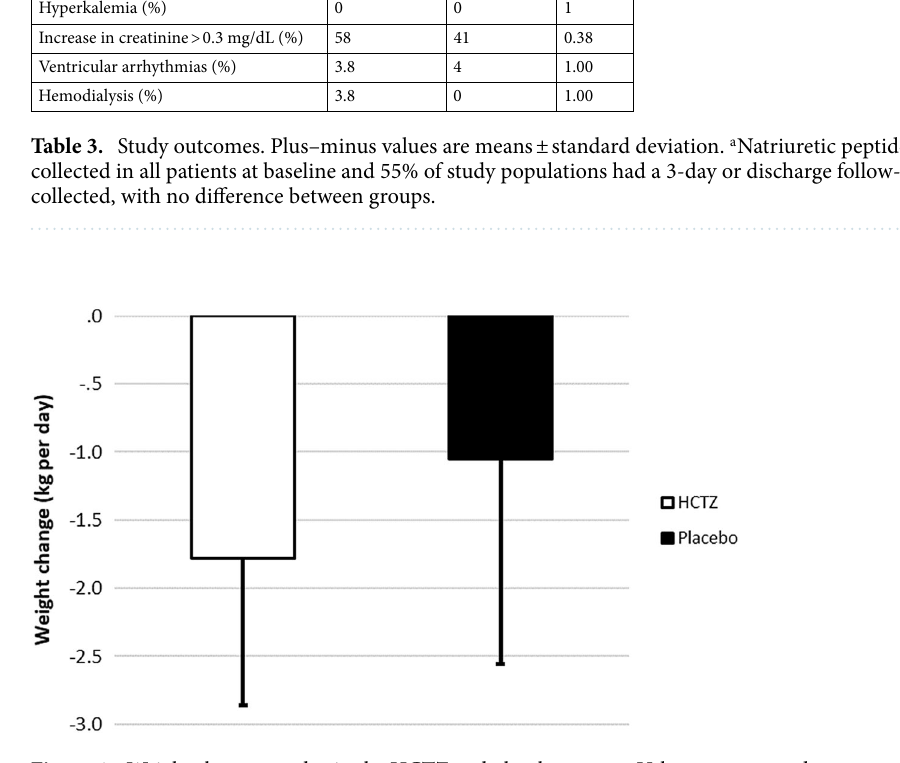
Figure 4. Weight change per day in the HCTZ and placebo groups. Values are reported as mean ± standard deviation (kg/day). HCTZ: − 1.78 ± 1.08 kg/day; placebo: − 1.05 ± 1.51 kg/day; p =